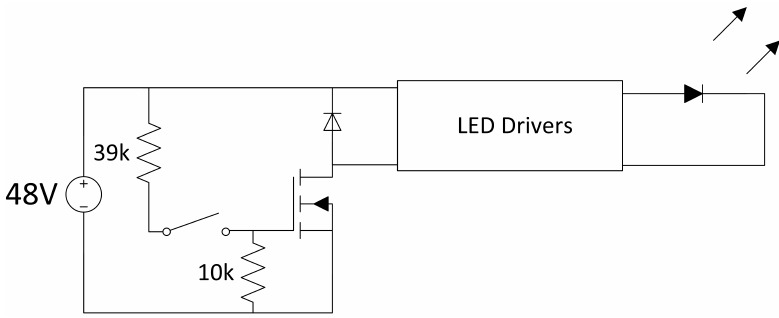
Figure 7. Controlling the DC current flow with a metal-oxide-semiconductor field-effect